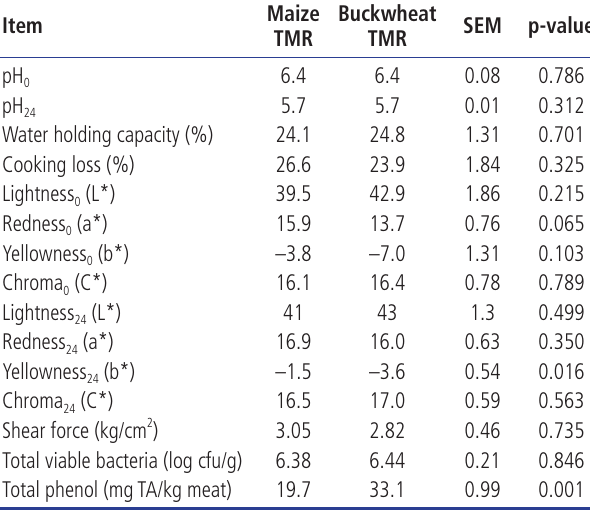
Table 5. Meat quality of MLD of lambs fed maize or buckwheat TMR